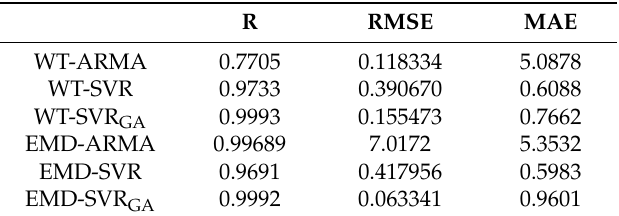
Table 5. Predict model test